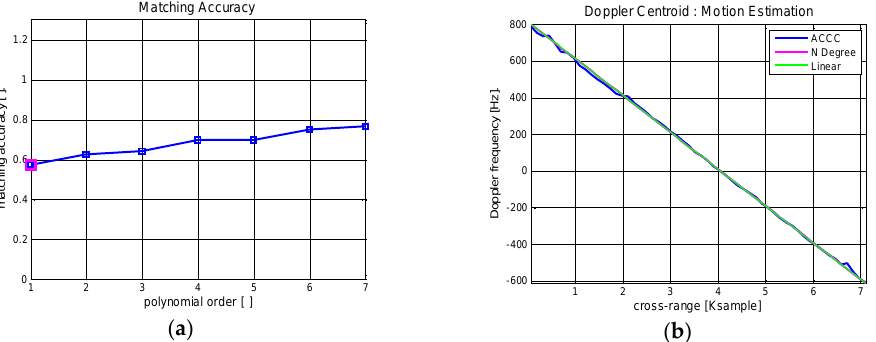
Figure 13. Motion index estimation of Boeing 747 ISAR: ( a ) Matching accuracy of polynomial fitting; ( b ) Doppler polynomial fitting results.